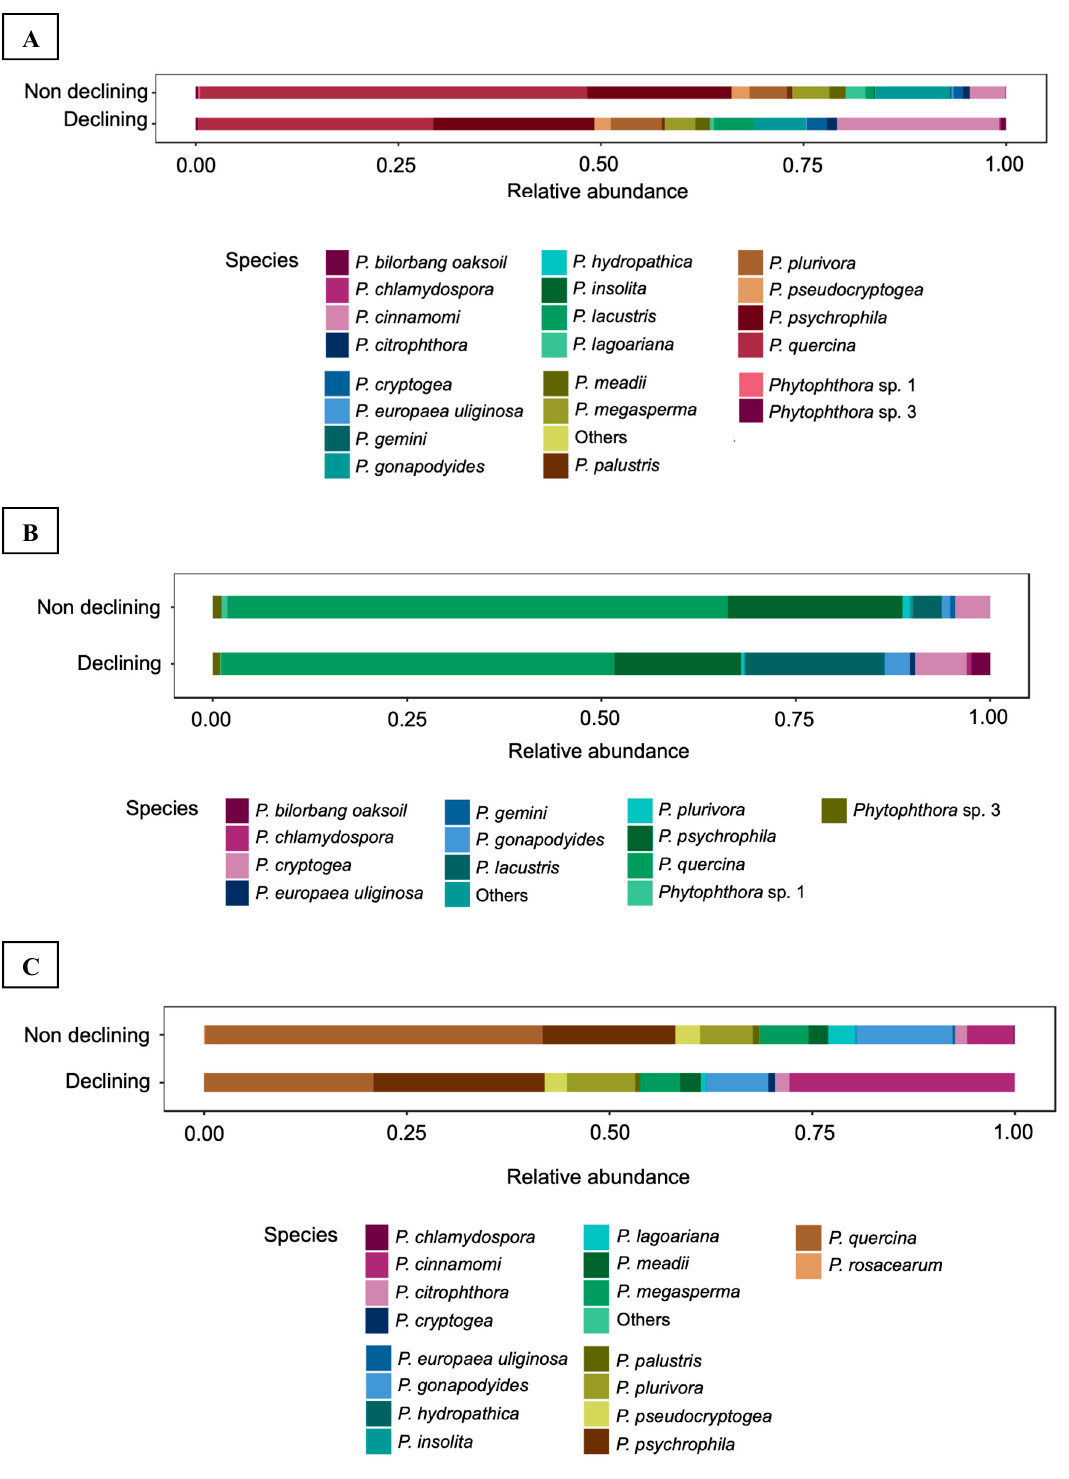
Figure 2. Relative abundance of Phytophthora species showing more than 1% relative abundance of all reads in Extremadura region according to the factor symptomatology. Species representing less than 1% of the total reads are grouped in others. ( A ): During the surveys conducted in 2012 and 2013. ( B ): Survey conducted in 2012. ( C ): Survey conducted in